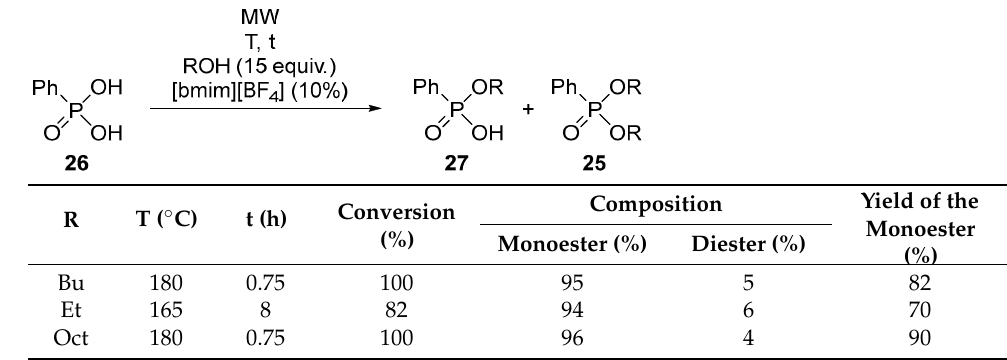
Table 4. MW ‐ promoted direct esterification of phenylphosphonic monoesters ( 27 ).